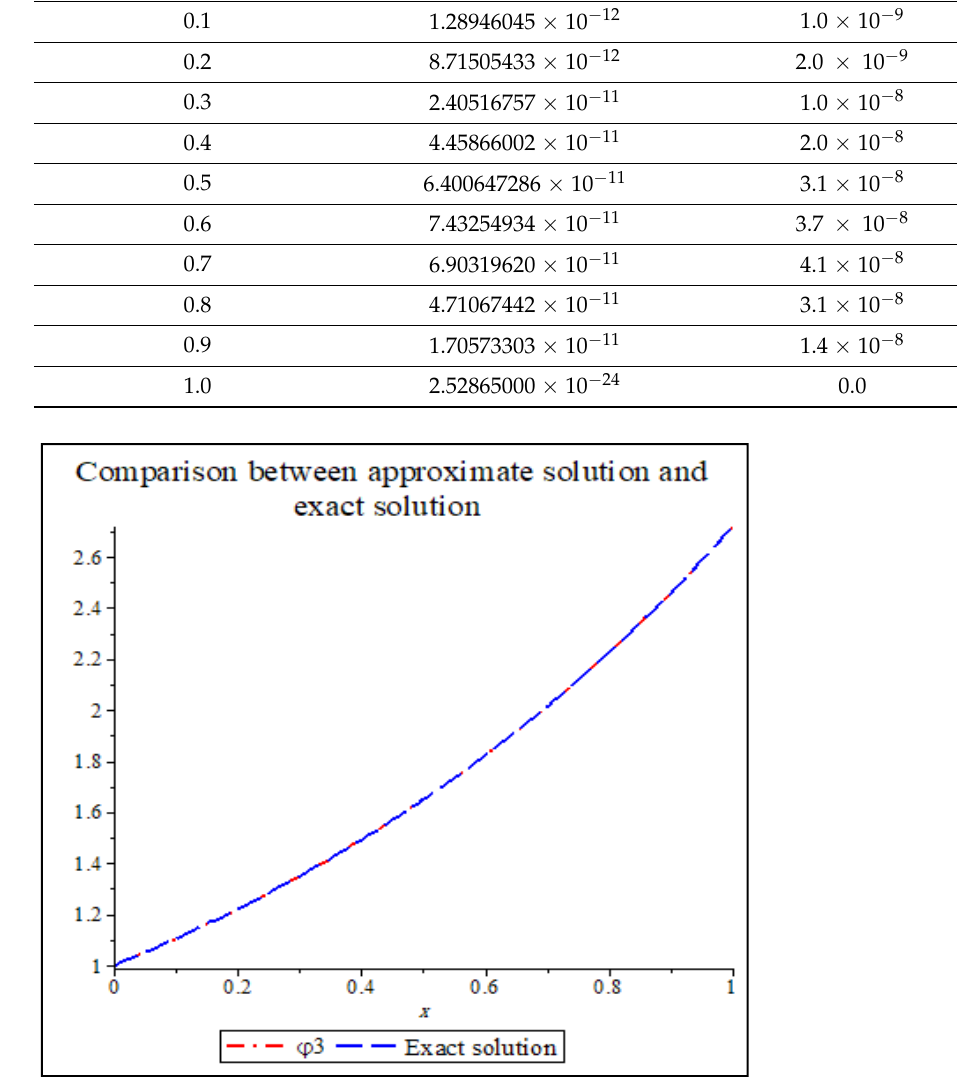
Figure 3. Comparison of the exact solution and the approximate solution of 𝜑 (cid:2871) in Example 3.